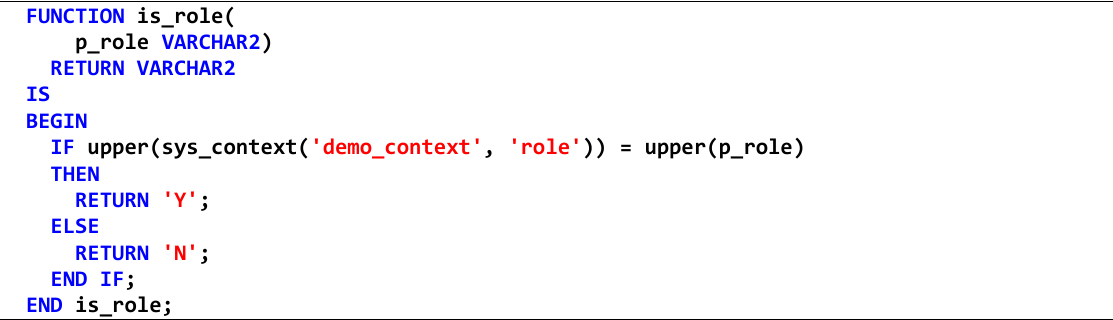
Figure A3. PL/SQL constraint